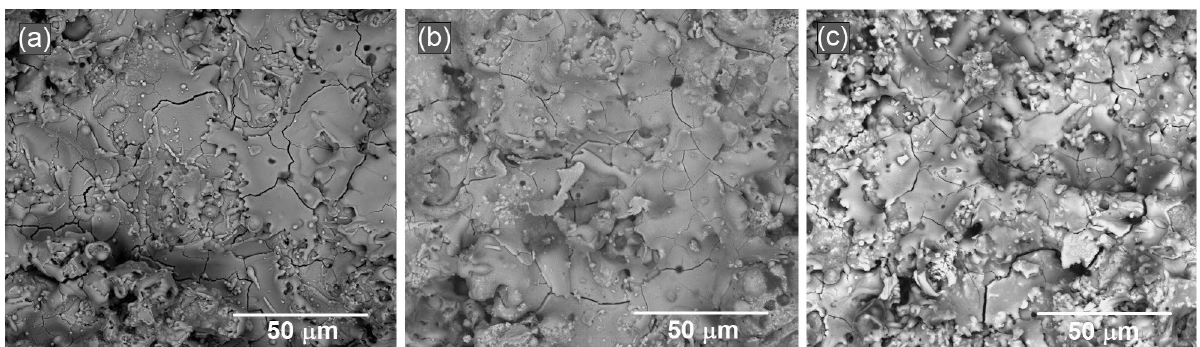
Figure 4. SEM images of as-sprayed top coatings CSZ, MSZ, and CSZ-MSZ by the APS showing surface microstructure of ZC3, ZM3, and Mix3 samples in ( a ), ( b ), and ( c ), respectively. Coated were performed on the 304 stainless steel substrate at plasma current of 700 A.